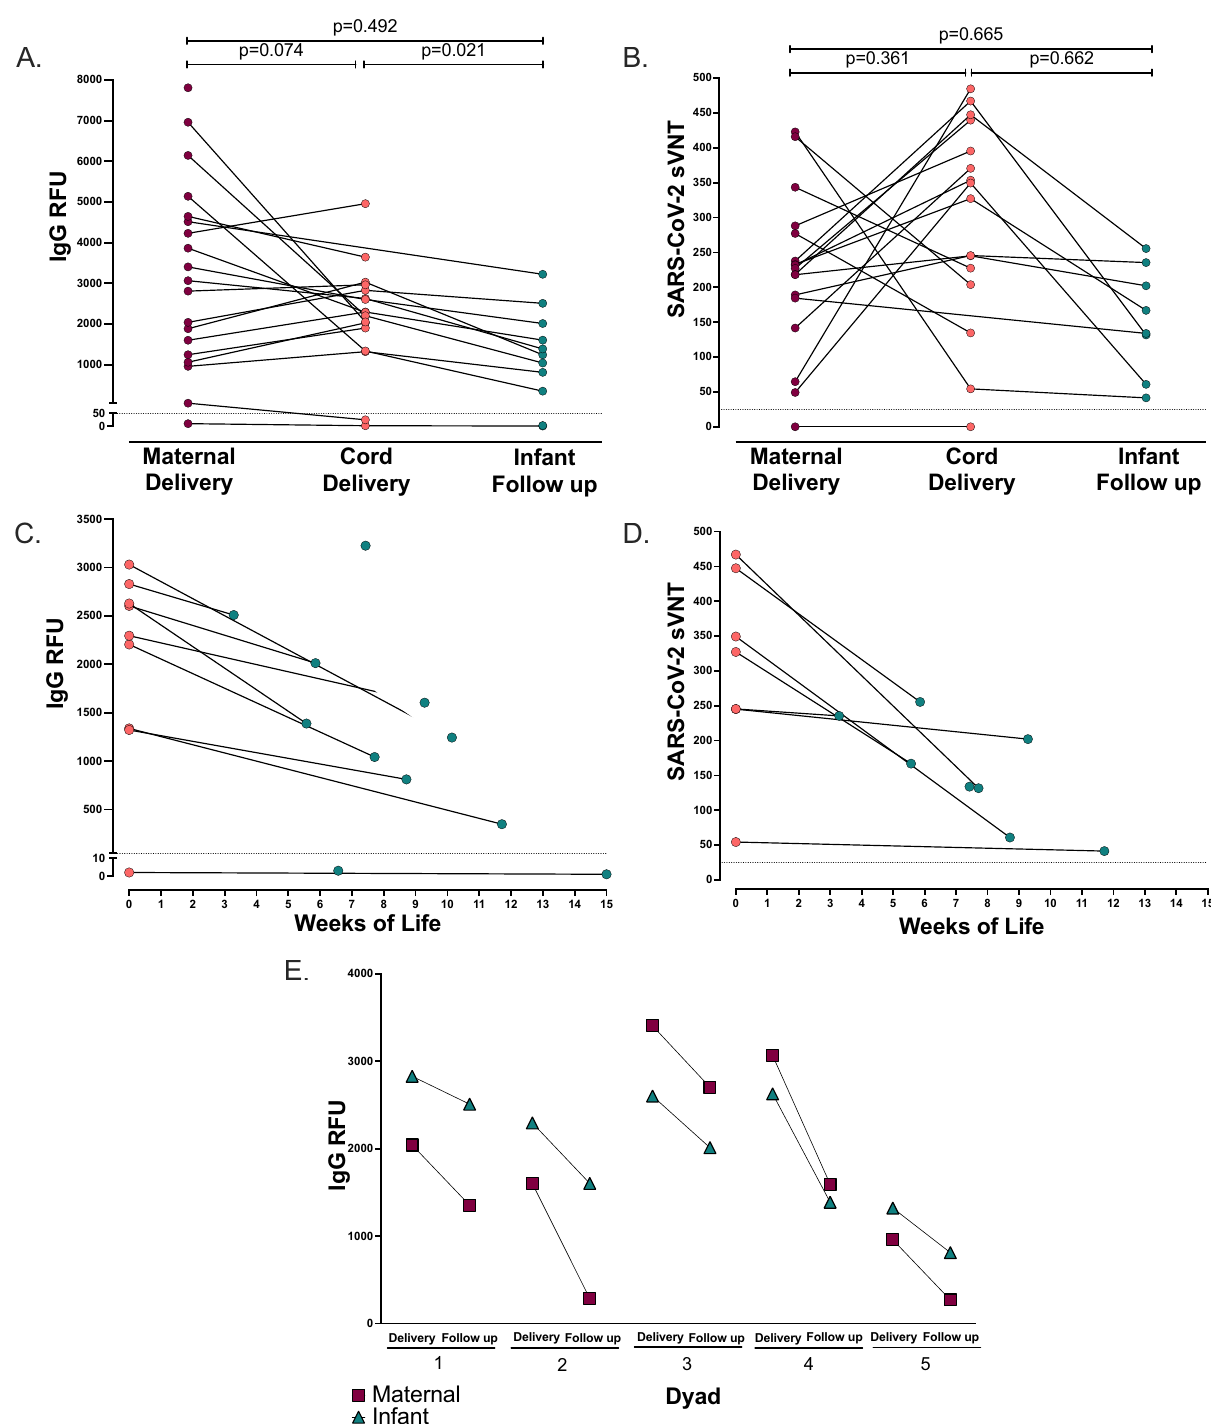
Fig. 2 | Paired maternal, cord, and infant IgG and neutralization antibodies. A Pairedmaternalplasmaatdelivery( n =19),cordplasma( n =17),andinfantfollow- up ( n =11) by anti-SARS-CoV-2 RBD/N IgG antibody relative fl uorescence units (RFU),(Spearman ’ srankcorrelation,dottedlineindicatespositivecutoffvalueof50 RFU). B Paired maternalplasma at delivery( n =17),cord plasma ( n =16), and infant follow-up ( n =8) by SARS-CoV-2 label-free surrogate neutralization assay (sVNT), (Spearman ’ s rank correlation, dotted line indicates positive cutoff value of 25).